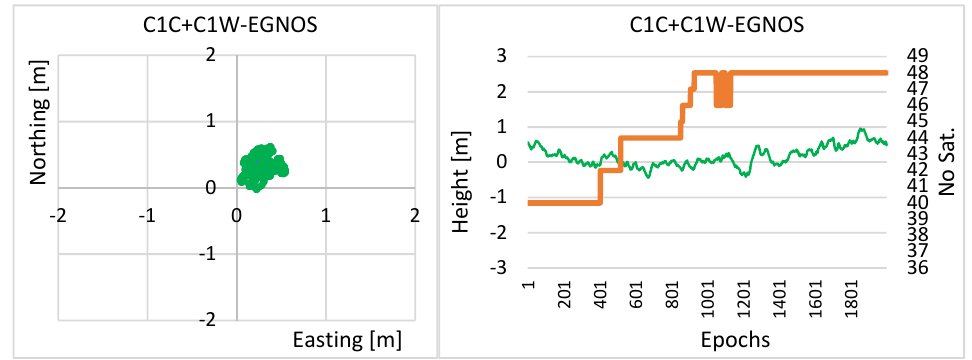
Figure 13. Real errors of coordinates of dual receiver in the constrained least squares adjustment of GPS/EGNOS positioning (Step IV, see Figure 1).